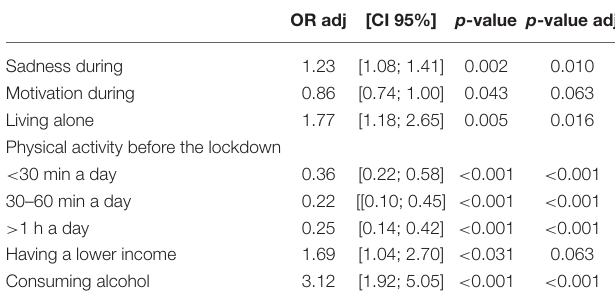
TABLE 6 | Multivariable analysis on increasing the tobacco use related to the